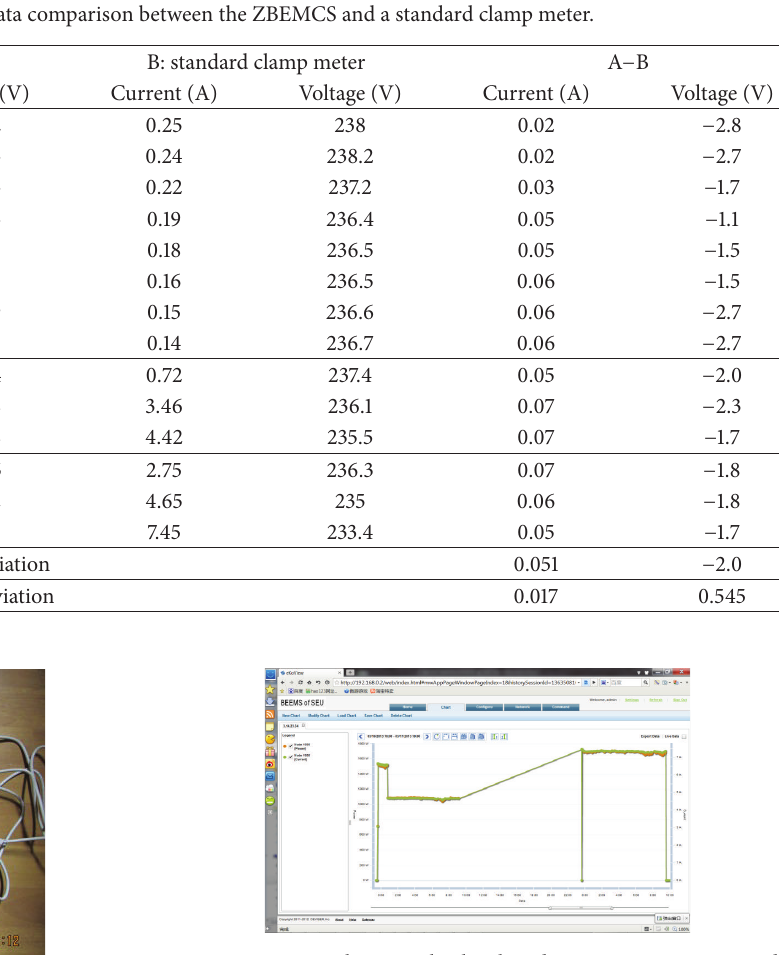
Figure 11: GUI showing the local and remote monitoring and control screen.